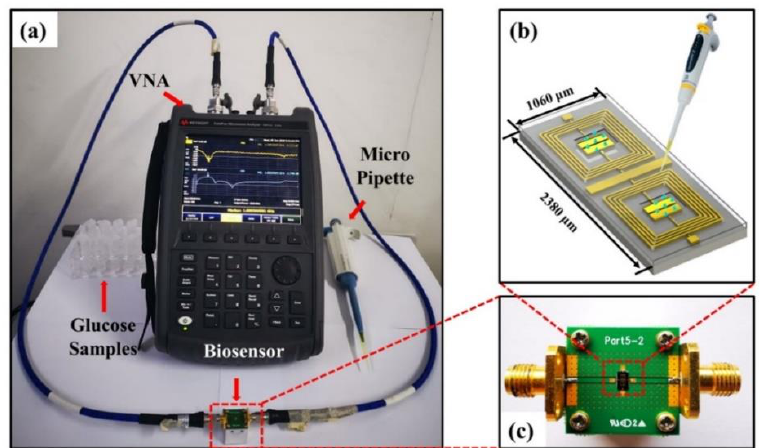
Figure 3. ( a ) The experimental setup of the proposed chip measurement for detecting variable glucose level. ( b ) The schematic diagram of measurement. ( c ) The fabricated biosensor attached on a PCB with input and output connection for glucose level measurement.